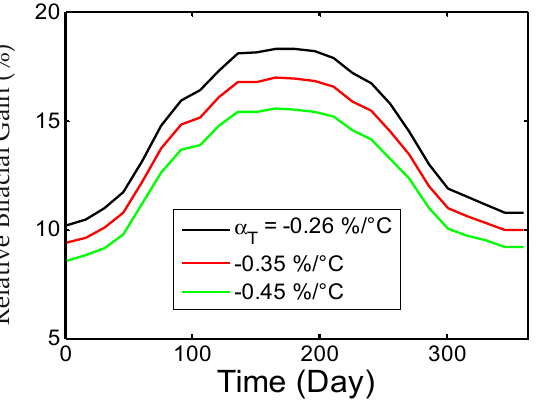
Figure 9. Modelled percent increase in relative bifacial gain over the course of the year of a six-module string for different values of the power temperature coefficient.